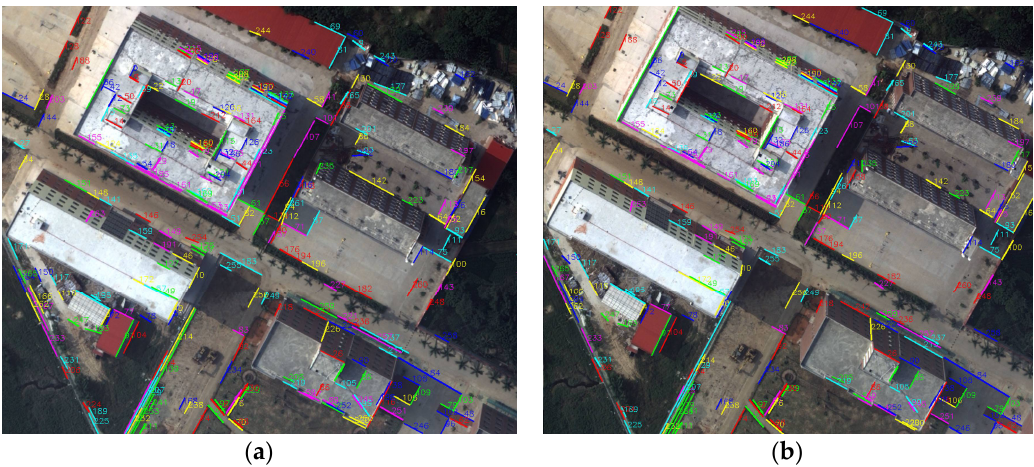
Figure 6. The line matching effect of the LJL method on a conventional down-looking image pair. ( a ) First image; ( b ) Second image. Table 1. Line matching results of a conventional image pair.